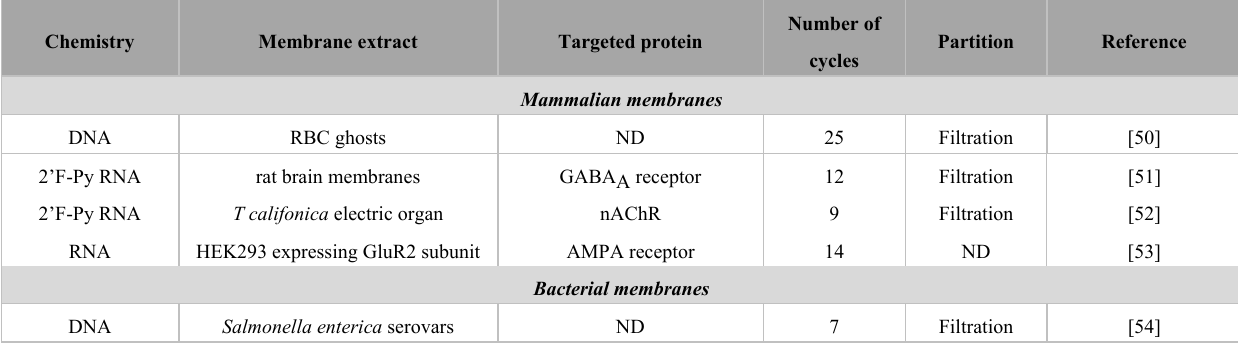
Table 2. SELEX directed against membrane